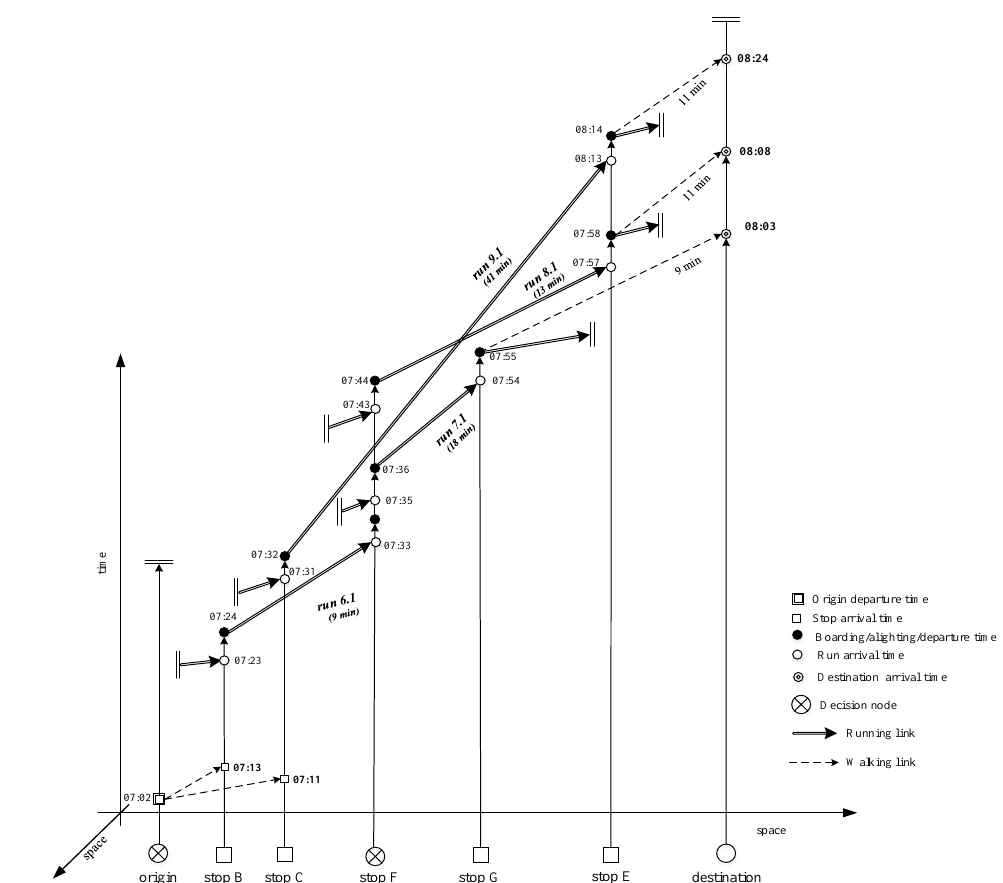
Figure 6. Run-based representation of transit services relative to nodes B and C , with at-origin forecasted bus arrival times at downstream nodes.